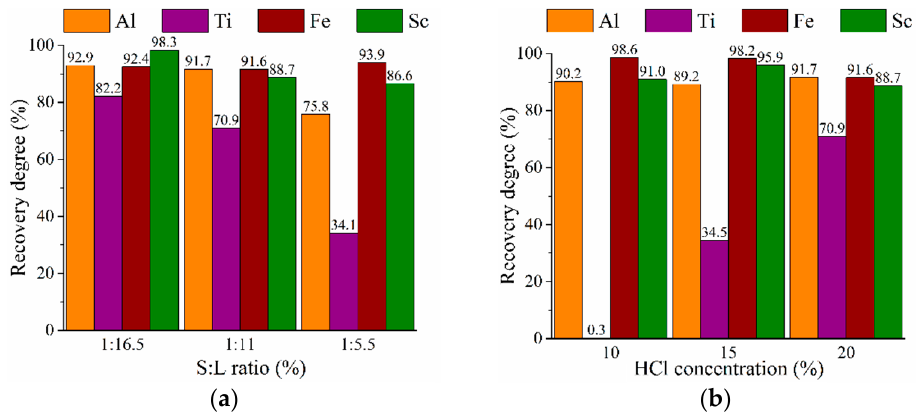
Figure 13. Effect of S:L ratio on the recovery degree of Al, Ti, Fe, Sc at 150 °C and 20% HCl ( a ) and effect of HCl concentration on recovery degree of Al, Ti, Fe, Sc at 150 °C and S:L = 1:11 ( b ).